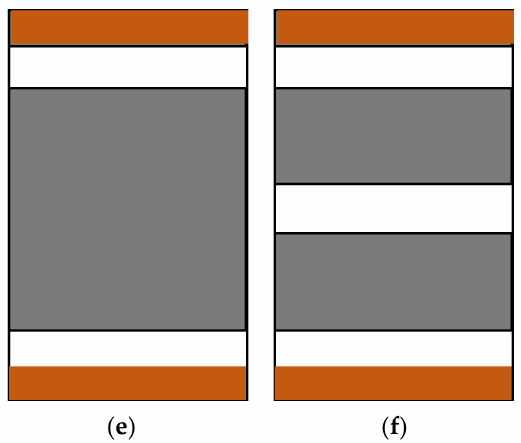
Figure 16. Sample configurations: ( a ) uniform pollution layer; ( b ) dry band near HV electrode ( c ) dry band near the middle region ( d ) dry band near ground electrode ( e ) Dry bands near high voltage and ground electrode ( f ) Dry bands near middle region, high voltage and ground electrode.